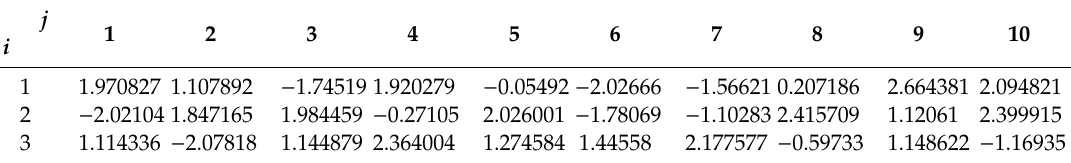
Table 5. Weights W ij from the i th input layer to j th hidden layer.